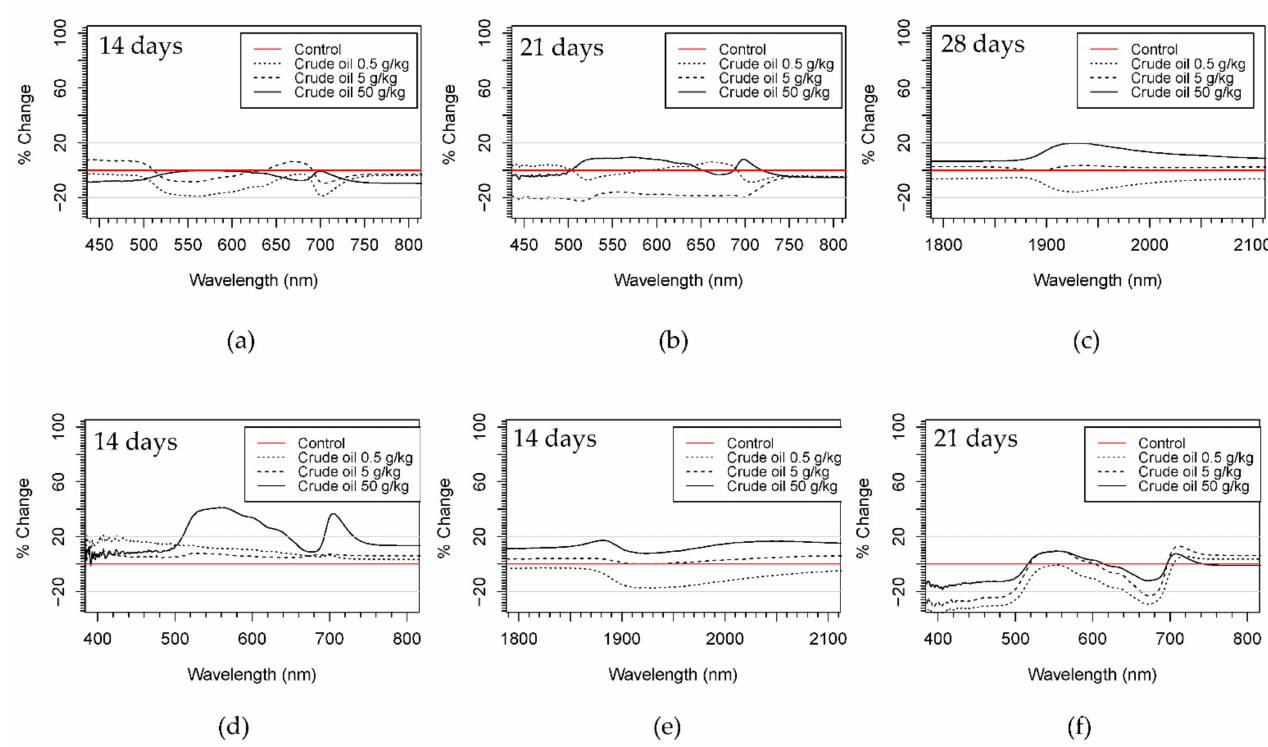
Figure 5. Ratios of reflectance change of crude oil treatments respect to control treatments in willow ( a – c ) and maize plants ( d – f ) in different parts of the spectra and on different days of the experiment. Red line representing the control was calculated using the standard deviation as is indicated in Equation